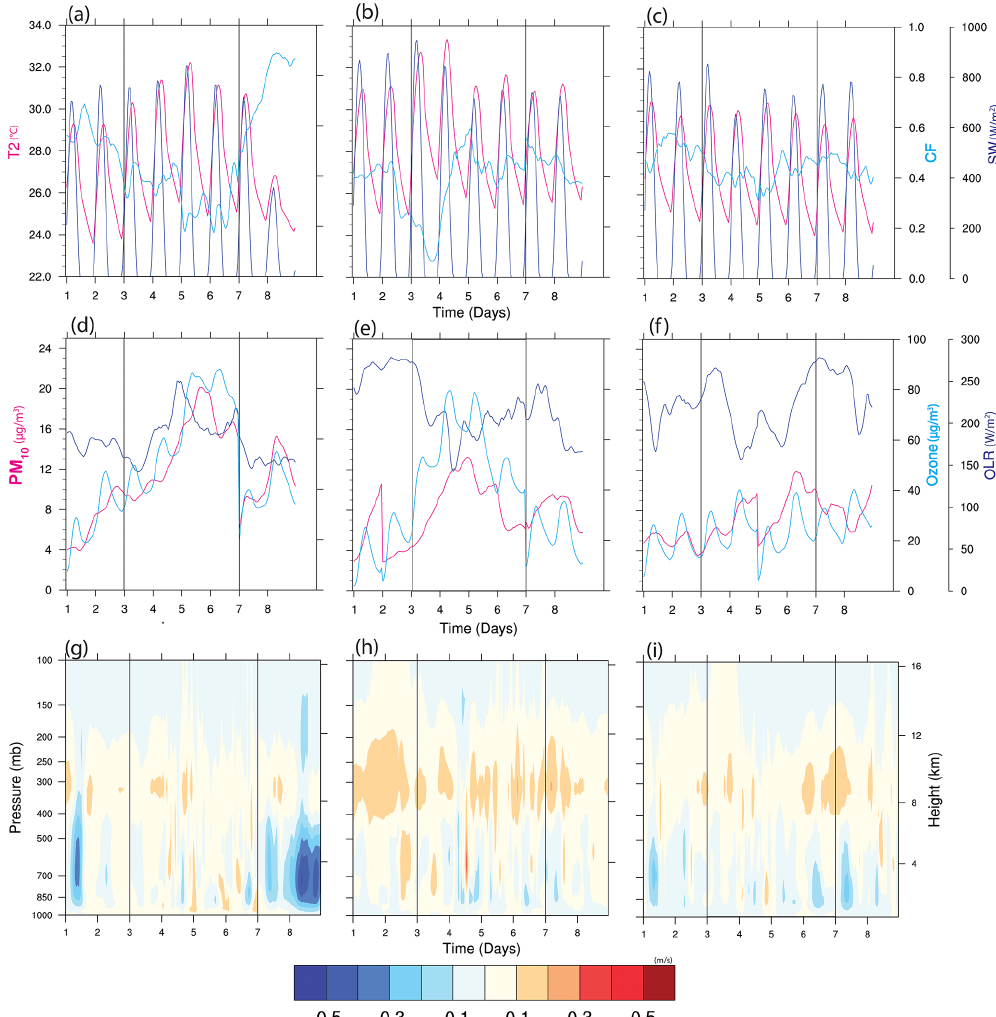
Figure 1. The model (CTRL) domain-averaged results for air temperature at 2m ( T 2 ; magenta), cloud fraction (CF; cyan) and incoming shortwave radiation (blue) at ground level for (a) TC-HPE, (b) ST-HPE and (c) HY-HPE and PM 10 (magenta), O 3 (cyan) and outgoing longwave radiation (OLR) at the top of the atmosphere (blue) for (d) TC-HPE rep , (e) ST-HPE rep and (f) HY-HPE rep . Time series of vertical velocity (color shading) for (g) TC-HPE rep , (h) ST-HPE rep and (i) HY-HPE rep . Positive vertical velocity means downward motion, whereas negative vertical velocity means upward motion. Black boxes represent the period of HPEs. Days 1 and 2 were before the HPEs, days 3–6 were during the HPEs and days 7 and 8 were after the